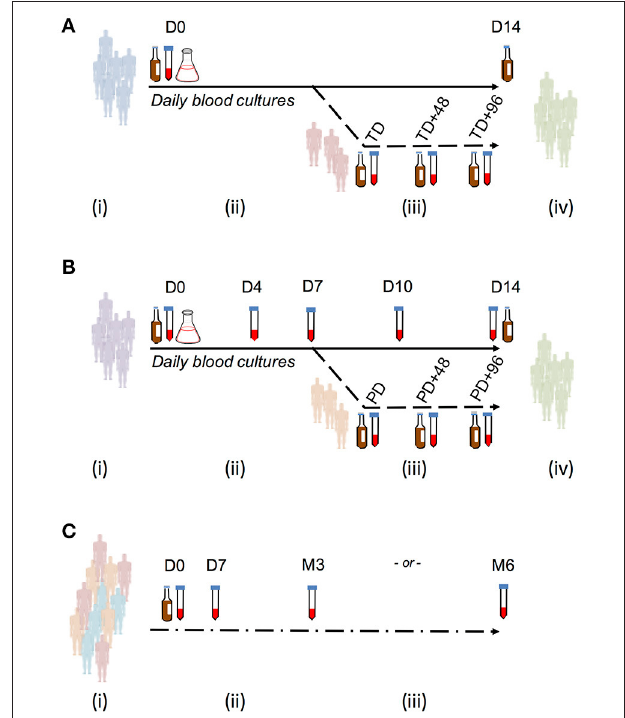
FIGURE 1 | Study sample collection for use in evaluating ALS responses as a diagnostic test for enteric fever. (A) Typhoid challenge study